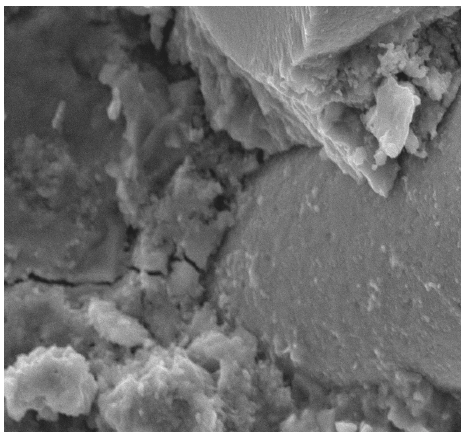
Figure 14. Microcracking near the optical fiber at 1000× magnification.